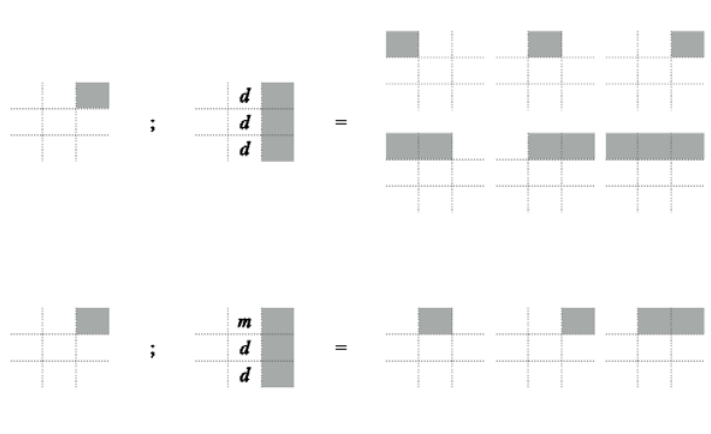
Figure 18: The strong composition of the direction relation matrix in the presence of topo- logical augmentation. The distinction between disjoint and meet allows for distinguishing opportunities based on the maximum rectangle algebra relation that could be present be- tween the objects [4, 13,